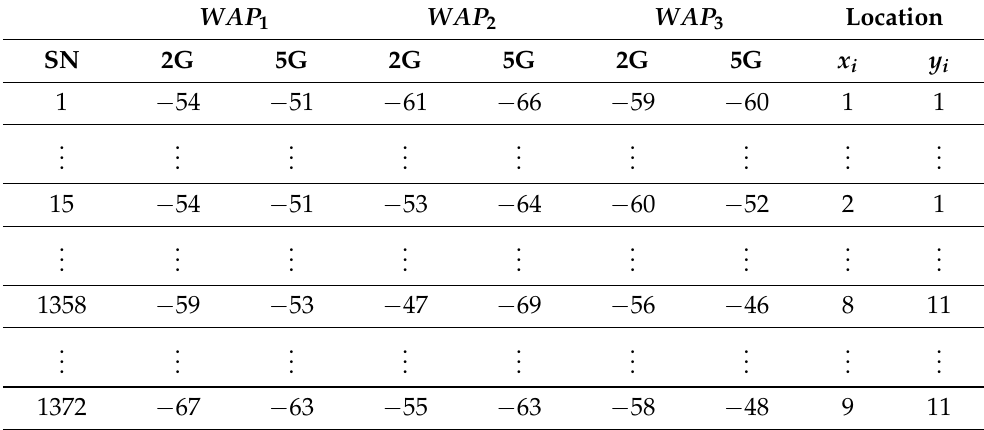
Table 2. A sample of Received Signal Strength Indicator (RSSI) values with measurement